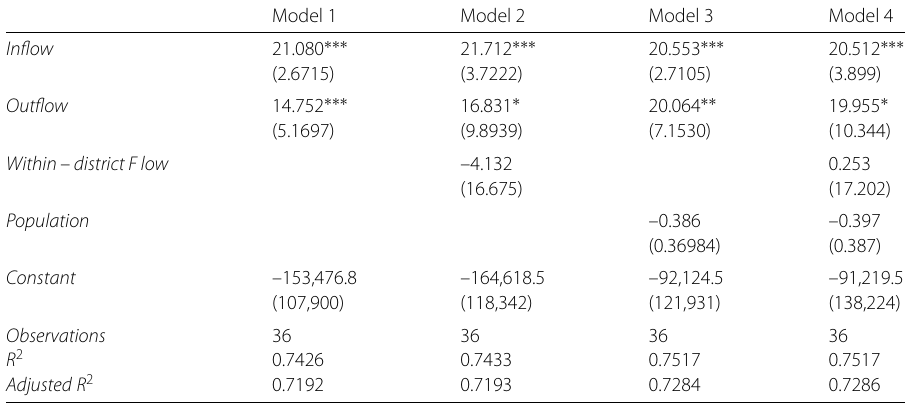
Table 3 Regression coefficients for prediction of Economic Productivity using Human Flows